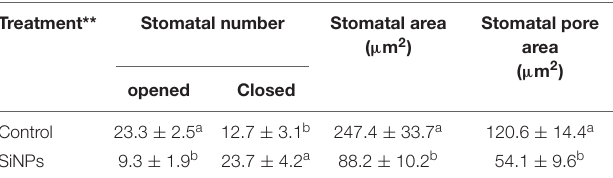
TABLE 9 | Scanning electron microscopic observations on the average number of closed and opened stomata (field area = 0.195 mm 2 at 250X magnification), stomatal area, and stomatal pore area (at 4500X magnification) in the leaves of grapevines infected with downy mildew in response to foliar application of SiNPs at 150 ppm.*